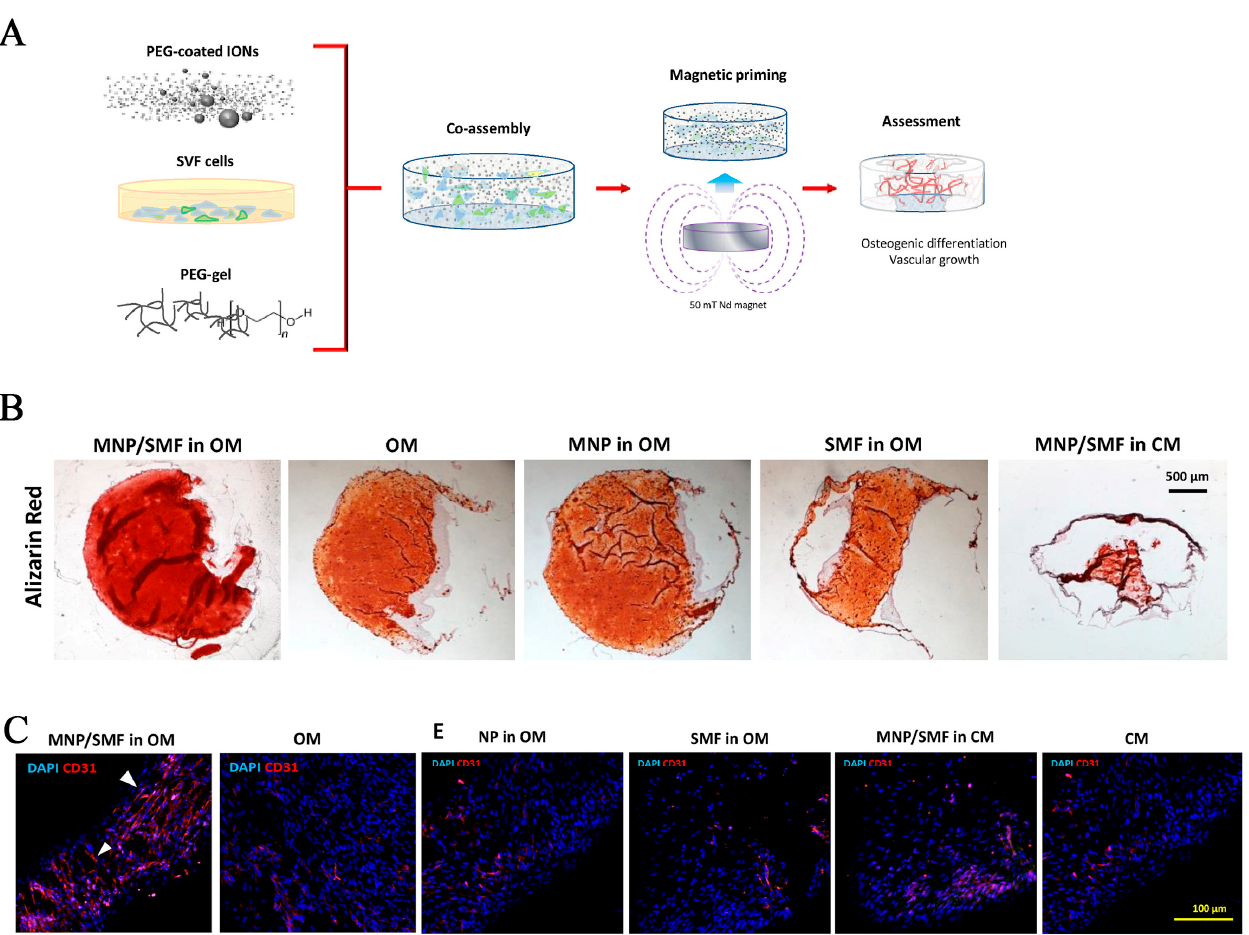
Figure 7. ( A ) The formation of magnetic hydrogels via co-assembly of cells, particles and PEG gels, and their stimulation under an external magnetic field. ( B ) Alizarin red staining was performed to evaluate the level of calcium deposition (in red). ( C ) Percentage of CD31+ cells cultured for 3 weeks by confocal microscopy to assess angiogenic capacity. (Osteogenic medium, OM, or culture medium, CM). Reprinted with permission from [90].